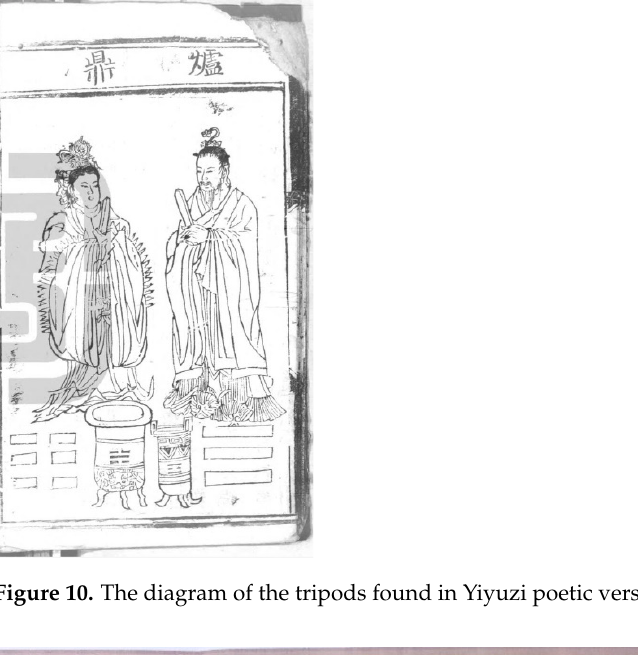
Figure 11. The diagram of the tripods found in the colored scroll version 34 .